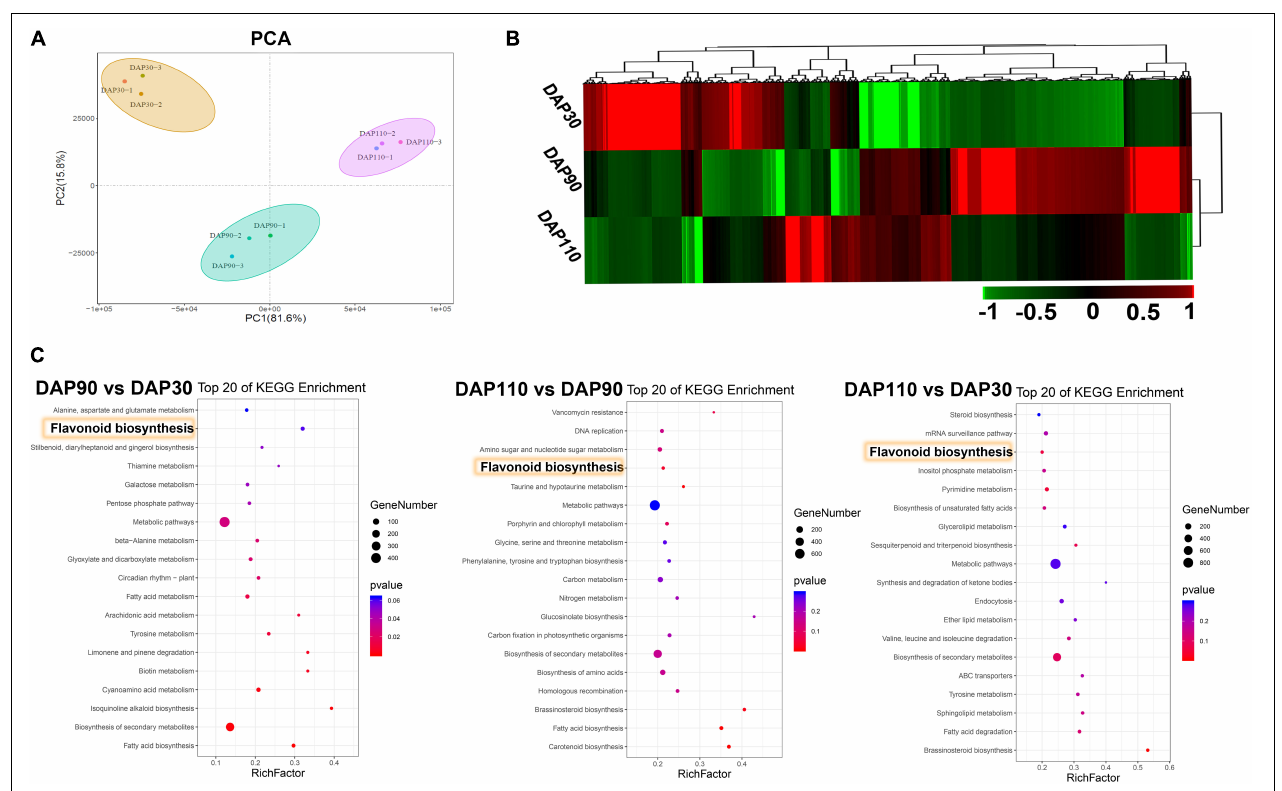
FIGURE 2 | Transcriptome analysis during the development of ‘Junzao’ jujube fruit skins. (A) Principal component analysis of the transcriptome data. (B) Expression patterns of DEGs at three developmental stages of jujube fruit skins. (C) KEGG enrichment analysis of DEGs from three comparisons of jujube fruit skins at different developmental stages (DAP90 vs. DAP30, DAP110 vs. DAP90, and DAP110 vs. DAP30). Yellow rectangles highlight the flavonoid biosynthesis